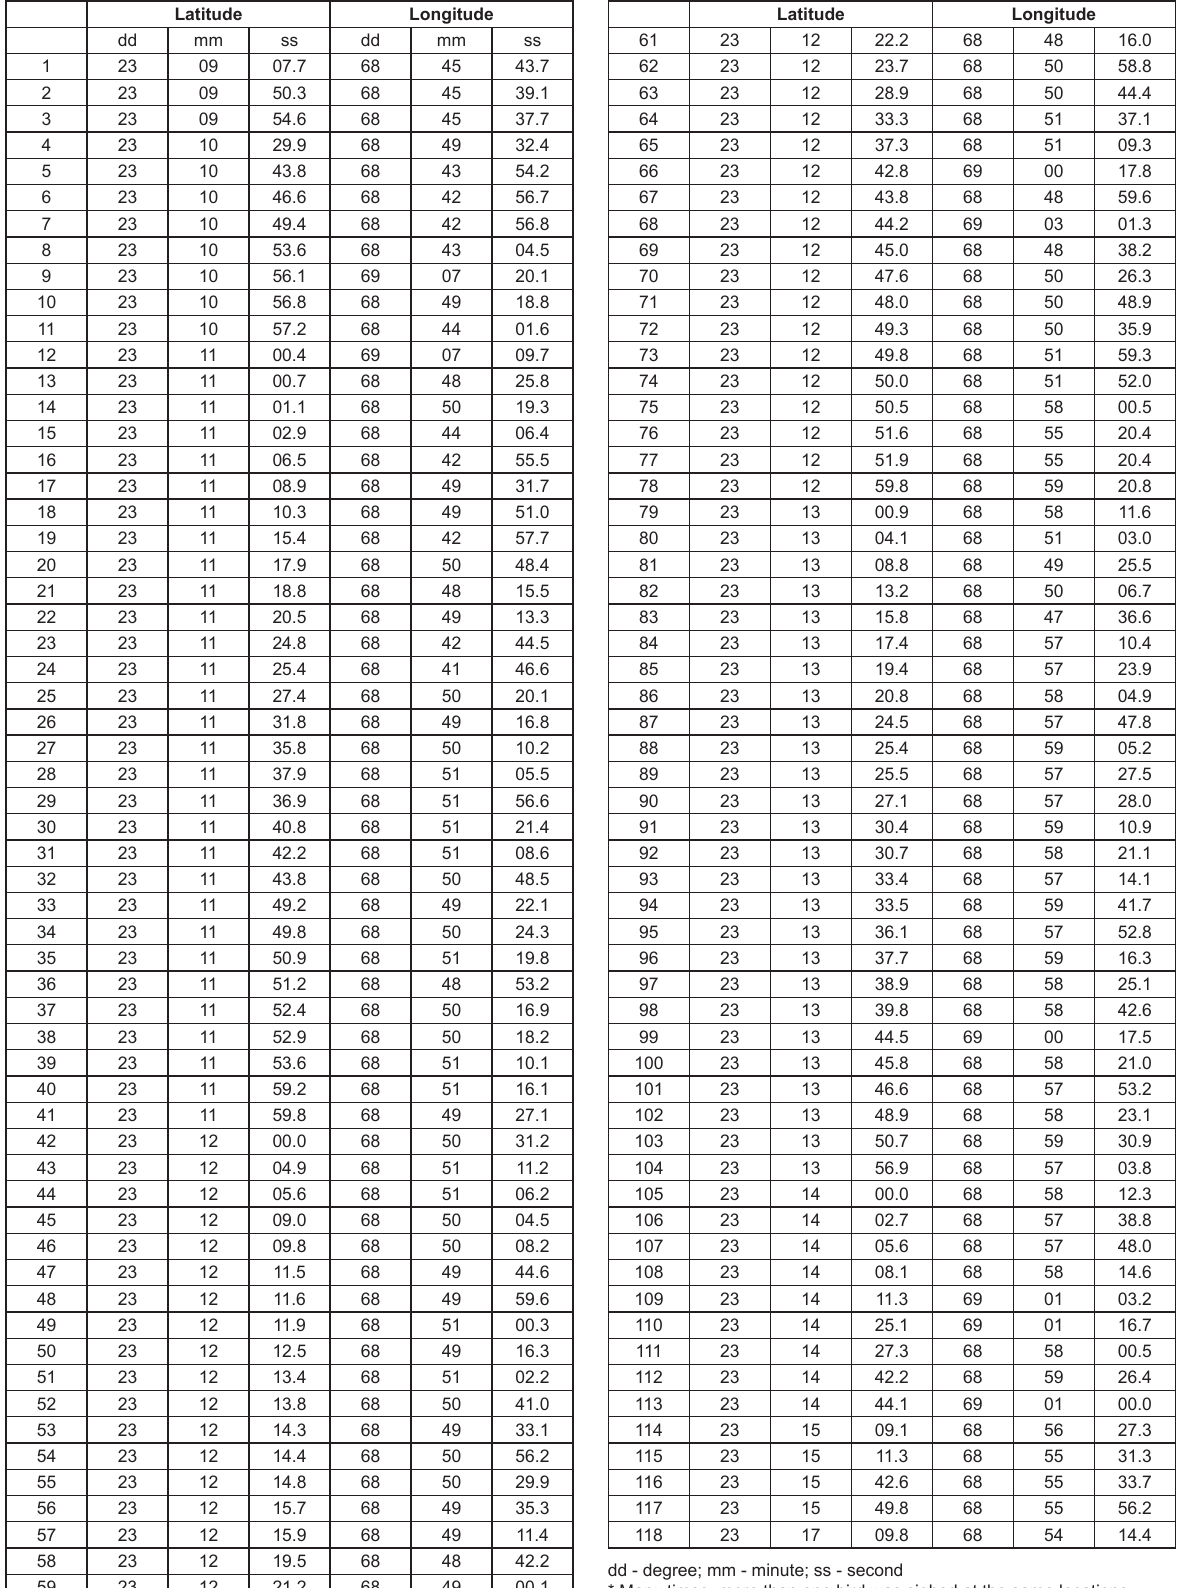
Table 1. GPS coordinates of Indian Bustard’s sightings in study